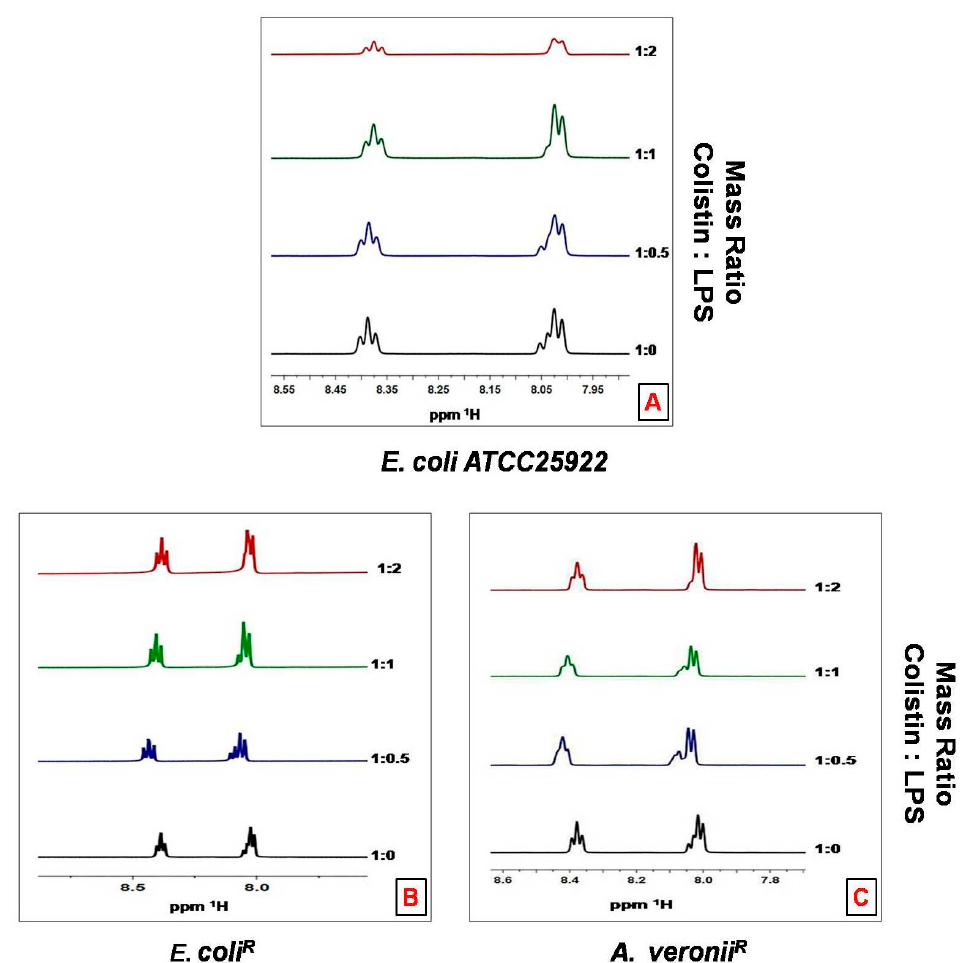
Figure 6. 500 MHz 1 H NMR spectrum of the amide region of colistin in 10% D2O pH 4.0 titrated with LPS aggregates. The ratio of LPS to colistin is indicated on the right ordinate ( A ) E. coli ATCC 25922 ; ( B ) E. coli R ; ( C ) A. veronii R .